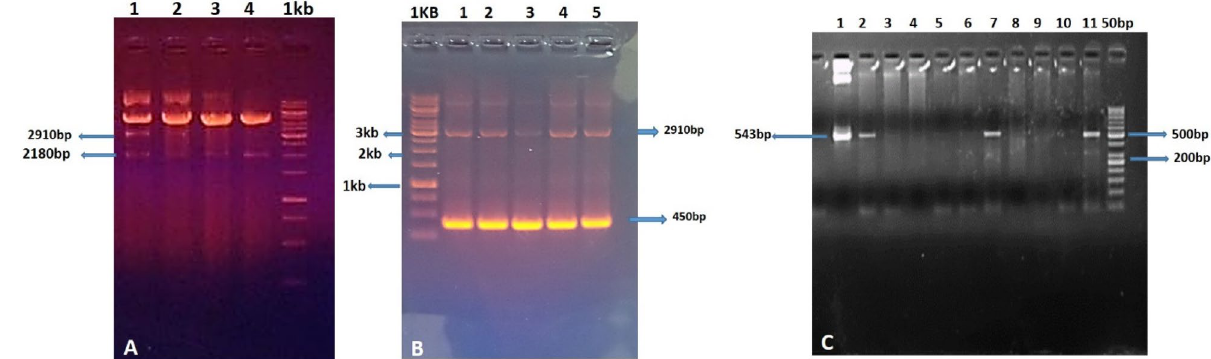
Figure 2. ( A ) Restriction digestion picture demonstrates excision and show confirmations of dual promoters (CmYMV-Ubi), 2910 bp cut with KpnI & BamHI (lane 4) and ThSyGII (CEMB-SIG2) 2180 bp, cut with BamHI & HindIII (lane1, 2 & 3), lane 5 shows undigested plant expression vector while lane 1 shows 1 Kb ladder ( B ). Restriction digestion of promoters from bacterial cloning vector cut with KpnI and BamH1 . ( C ) PCR amplifications of ThSyGII trigerred by sequence specific primers showing amplicon (543 bp) in lanes 1, 2, 7 and 11 while L lane indicates 1 kb ladder. Complete original uncropped gel pictures are provided in supplementary information file as fig. S-2A, S-2B and S-2C.